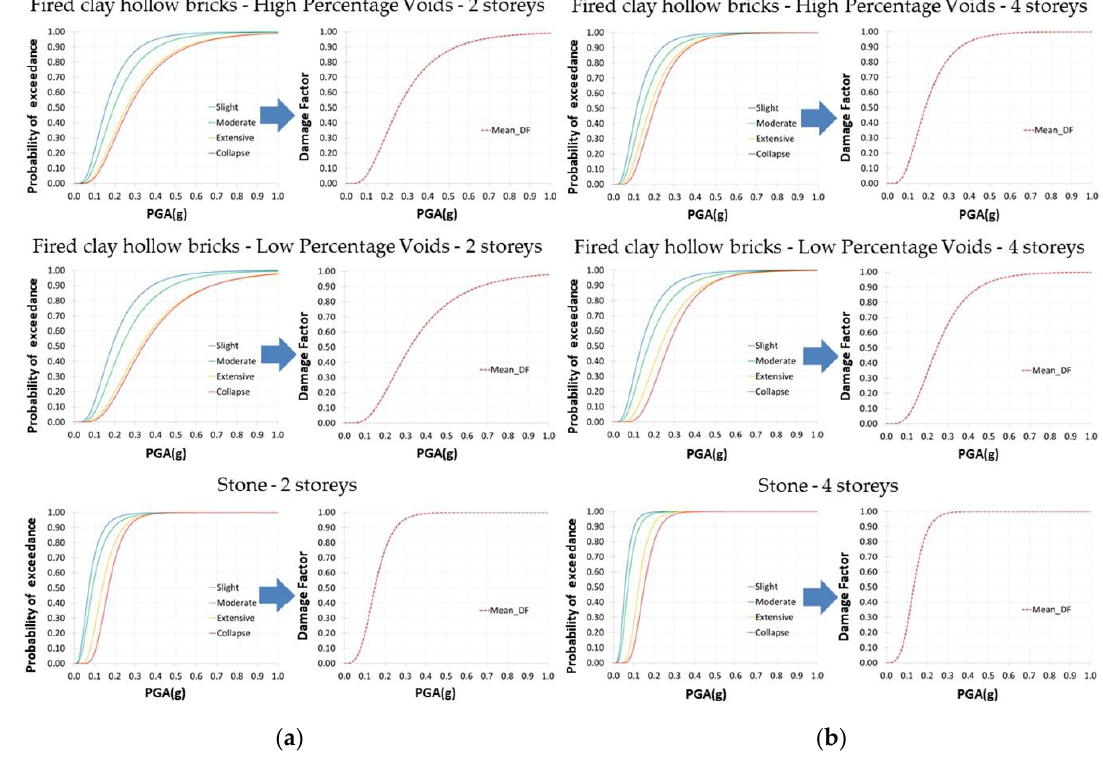
Figure 8. Vulnerability functions for typical unreinforced masonry buildings of (a) two storeys and (b) four storeys.